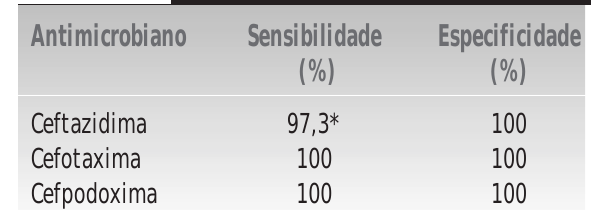
Figura 2 – Etest ESBL Screen ® positivo para o substrato cefotaxima em amostra de K. pneumoniae . Além da diminuição ≥ 3 escalas logarítmicas na CTL quando comparada com CT, a presença desta zona fantasma indica produção de ESBL devida ao sinergismo entre cefotaxima e cefotaxima/ácido clavulânico, MIC CT/CTL = 12/ 0,047 (cid:181) g/ml. CT = cefotaxima; CTL = cefotaxima + ácido clavulânico